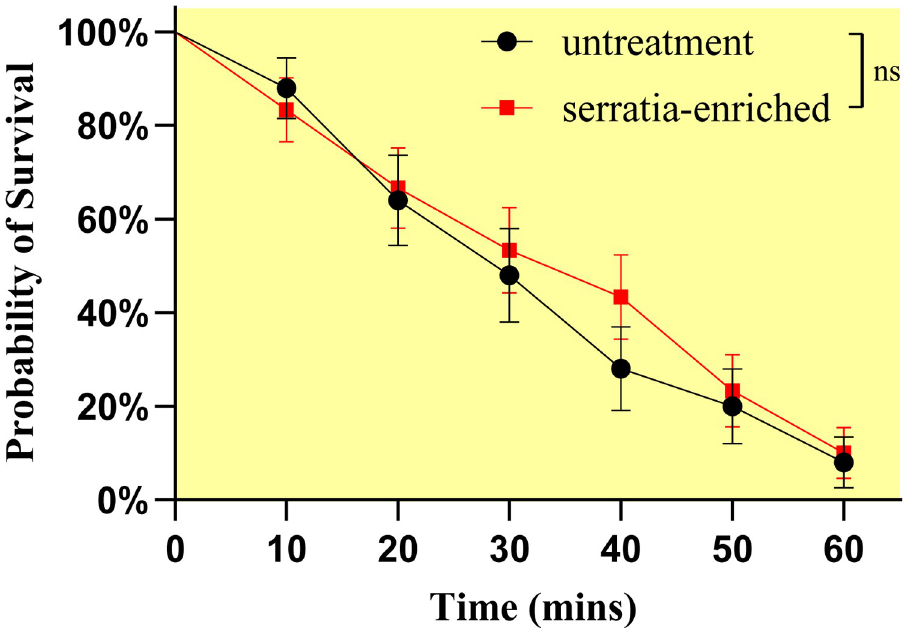
Fig 5. There was no significant difference in knockdown rate between the Serratia oryzae enrichment and control groups within 60mins. https://doi.org/10.1371/journal.pntd.0010208.g005 Table 3 shows the average residual concentration of deltamethrin in each group of media at different culture duration. We established the logistic multiple linear regression model with the average residual concentration as the dependent variable and the culture time and bacterial concentration as the independent variables. The regression equation: Y = 0.152–0.013 (Time)